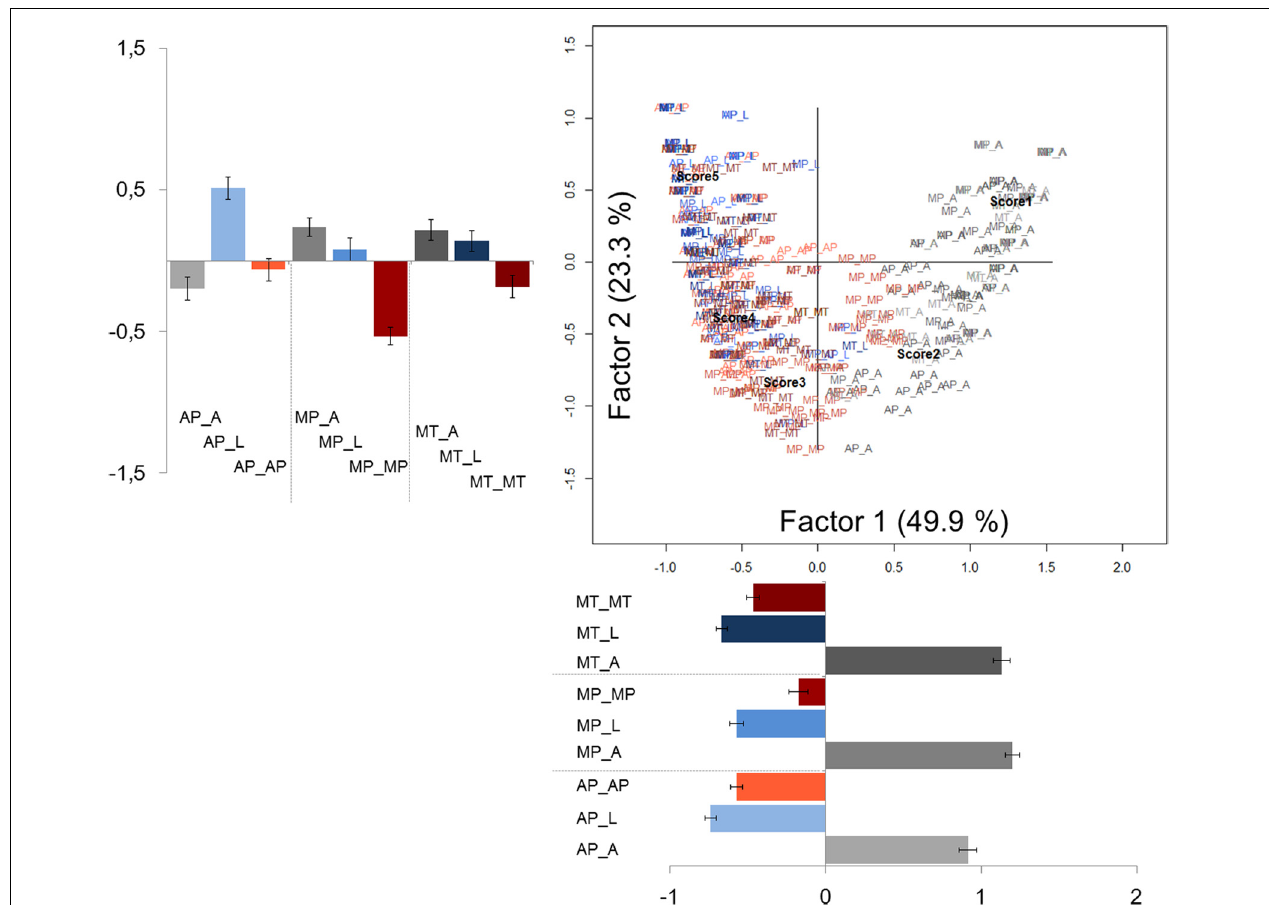
FIGURE 1 | Correspondence analysis for meaningfulness rating scores. The 378 sentences belonging to the three sets (Metaphor set = MP; Metonymy set = MT; Approximation set = AP) and the 5 Likert points are plotted at their corresponding coordinates. MP_MP: